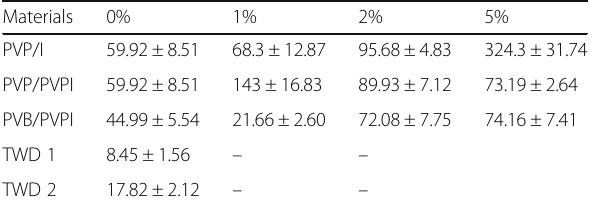
Table 2 Air permeability of the electrospun fibrous mats and two kinds of TWD (traditional wound dressing), with unit of mm s −